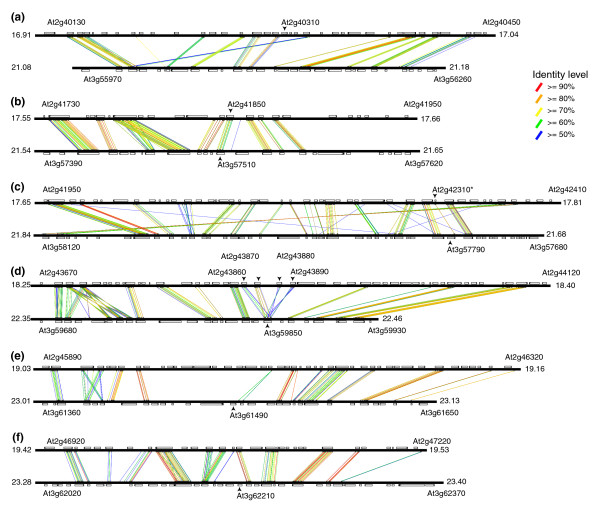
Collinearity of PGs in AGI block 23a. After locating areas with similarities in the block 23a (see also Additional data file 4), six distinct PG-containing regions were defined. (a) At2g40310 does not have PG in the collinear region. (b) At2g41850 and At3g57510 are located in collinear regions. (c) The 3' end of At3g57790 is highly similar to At2g42310*, a truncated PG that is likely a pseudogene. (d) A tandem of four PGs (At2g43860, At2g43870, At2g43880, At2g43890) is located in the collinear region with At3g59850. (e) At3g61490 does not have any PG in the corresponding collinear region. (f) At3g62210 does not have any PG in the collinear region. For each region pair, the solid black bars are the chromosomes (top: chromosome 2, bottom: chromosome 3) flanked by the starting and ending positions in Mb. The annotated genes are drawn to scale in a rectangular box on the chromosome and in each box the thicker black line indicates the 3' position of the gene. The names are only shown for PGs and the starting and ending genes in each block pair. The areas that are at least 30 amino acids long with at least 50% identity are linked by colored lines based on their identity levels (see key).